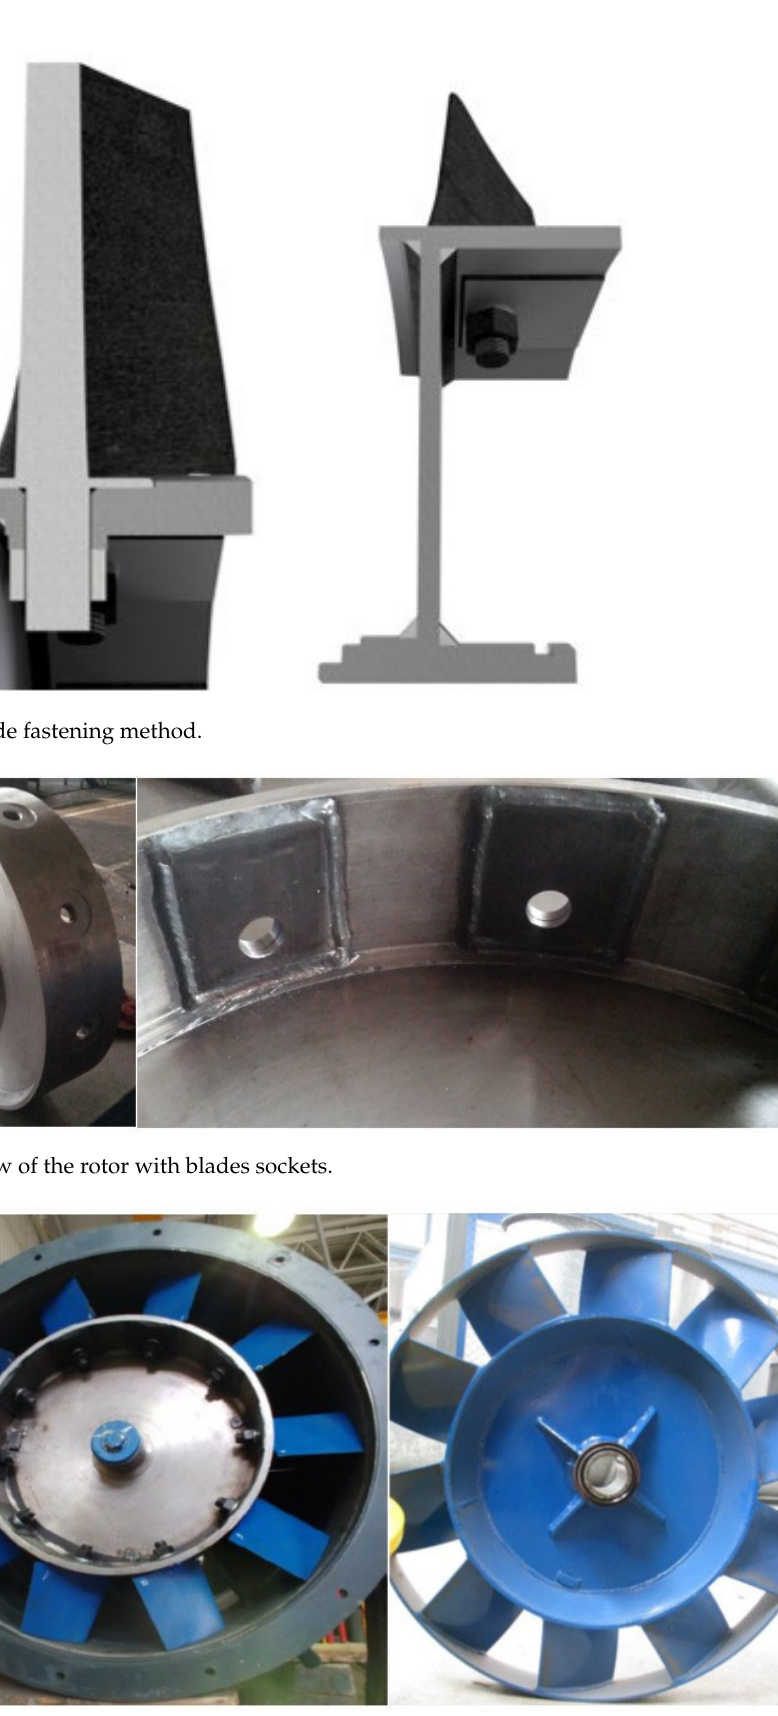
Figure 15. Comparison of the new ( left ) and datum ( right ) rotor design.